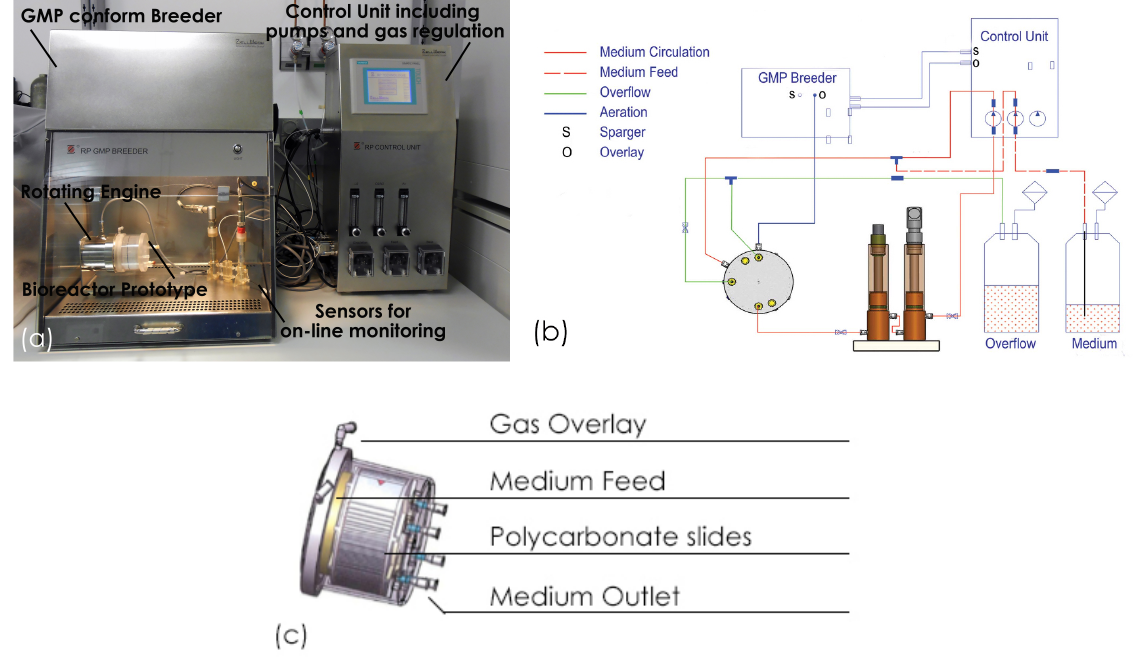
Figure 1. Z ® RP 2000 H (Zellwerk GmbH, Oberkraemer) bioreactor system with breeder and control tower ( a ) and disposable bioreactor ( b ) set up and ( c ) rotating bed consisted of polycarbonate cell carrier slides (total surface area 2000 cm 2 , reactor size 8.8 × 4.6 cm) (drawings adopted and modified from manufacturers manual and